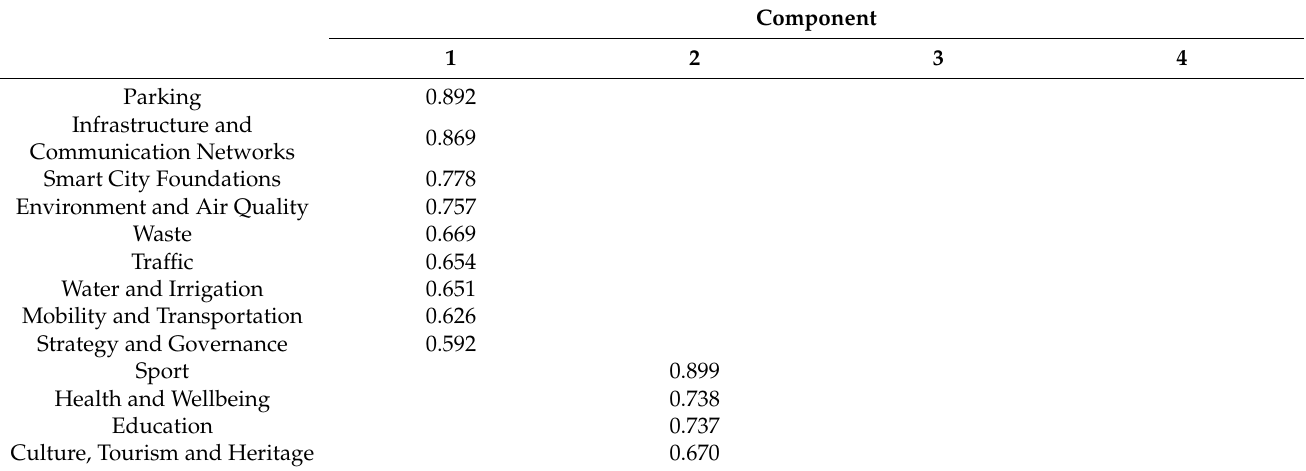
Table 2. Loadings of the principal component